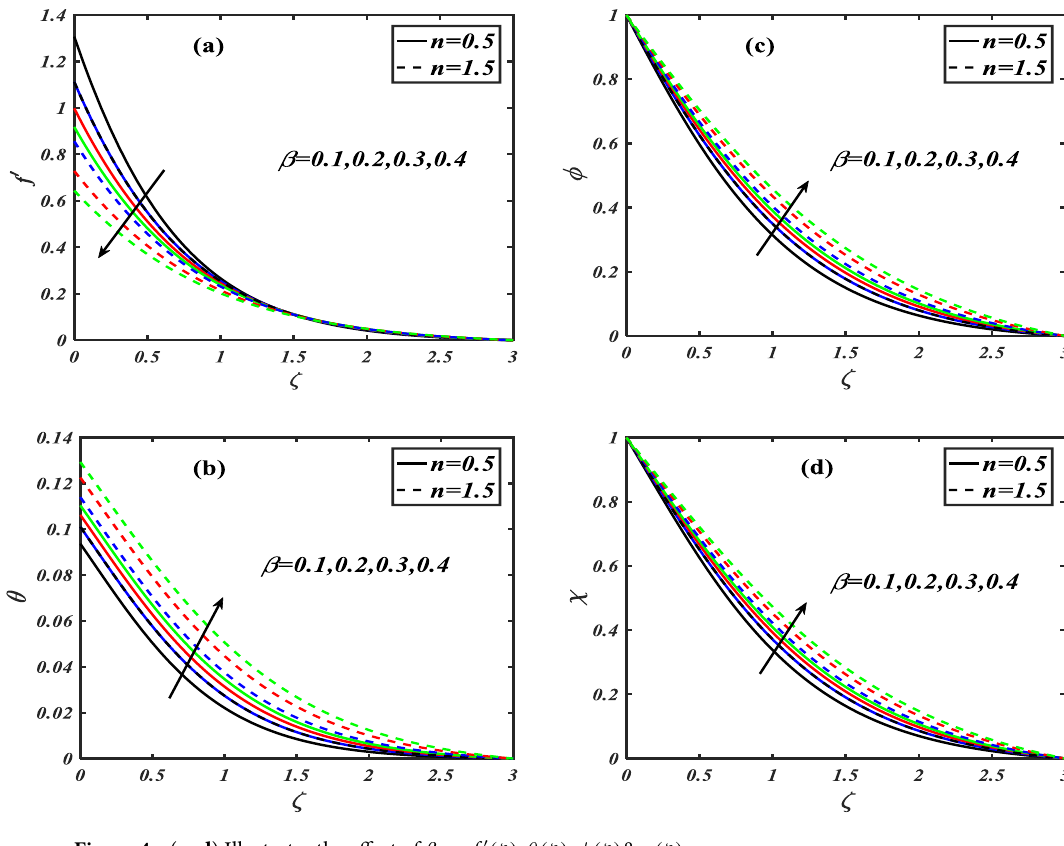
Figure 4. ( a – d ) Illustrates the effect of β on f ′ (ζ) , θ(ζ) , φ(ζ) & χ(ζ)